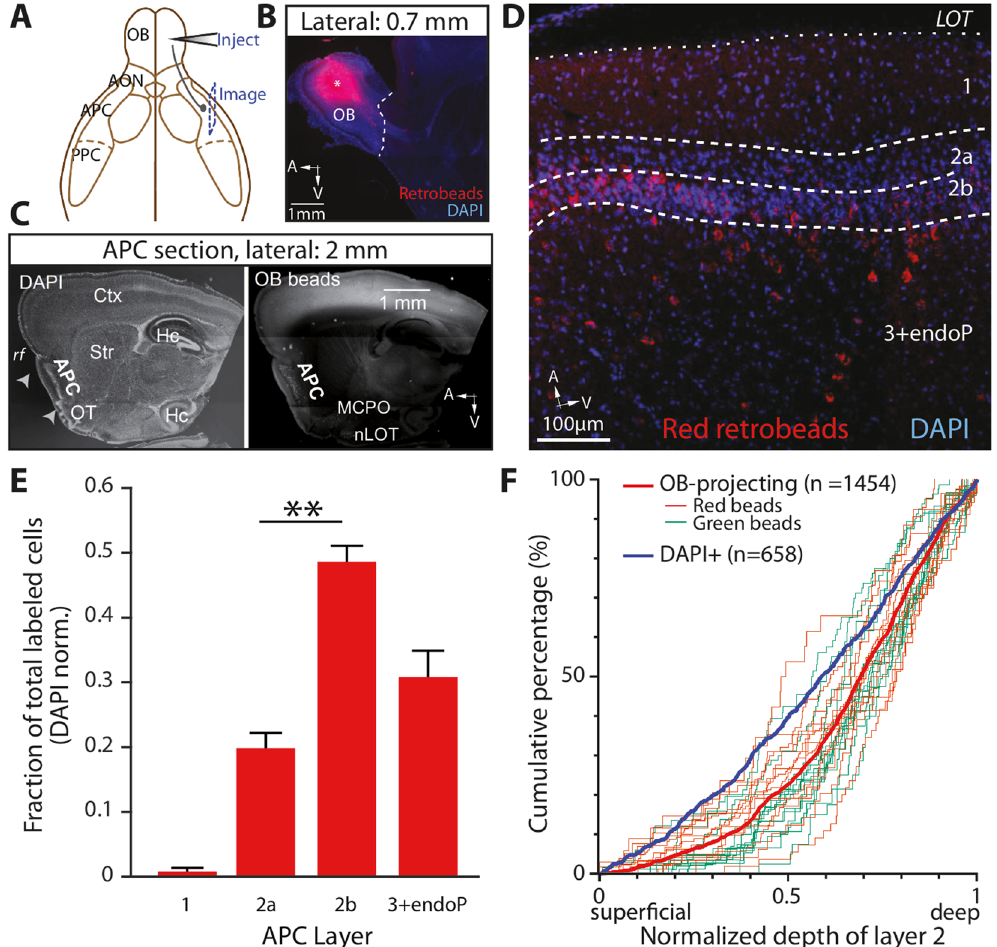
Figure 1. Layer 2b is the main source of feedback from the APC to the OB. ( A ) Schematic representation of injection of the tracer into the OB, and imaging from sagittal sections of the APC. ( B ) Injections were targeted to the granule cell layer of the OB. * , injection site. Red: retrograde tracer; blue: DAPI. ( C ) Representative sagittal section used for APC imaging. Left , DAPI labeling shows the main anatomical landmarks: dense cell layer 2 of the APC; rf: rhinal fissure; OT: olfactory tubercle; Hc: hippocampus; Ctx: neocortex and Str: striatum. Right , Retrogradely-labeled cells were found mainly in the APC in those sections. Some labeling was also observed in the MCPO: magnocellular preoptic nucleus and nLOT: nucleus of the lateral olfactory tract. ( D ) Higher magnification image showing retrogradely labeled cells across APC layers. Superficial limit of the layer 2 (border between layers 1 and 2a) is defined with a depth of 0 while a depth of 1 is the deep end of that layer (limit between layers 2b and 3). Red: retrograde tracer. Blue: DAPI. ( E ) Bar graph showing the relative fractions of retrogradely labeled neurons, normalized by the number of DAPI cells in each layer. OB-projecting neurons were heterogeneously distributed across APC layers (p < 0.0001, total cell count: 546 Retrobeads + , 4474 DAPI + cells, n = 13 sections, 11 mice, Friedman test). Within layer 2, cells were more densely found in layer 2b than in layer 2a (p = 0.005, n = 84 2a cells vs . 205 2b cells, Dunn’s multiple comparisons post-hoc test). ** P < 0.01. ( F ) Cumulative distribution of the OB-projecting cells within layer 2. On the x-axis, 0 indicates the border between layers 1 and 2a, while 1 is the limit between layers 2b and 3 (see panel D). The light green and red curves show the results from the counting obtained in a single optical section with green and red Retrobeads, respectively. Distributions obtained from green and red Retrobeads were not significantly different (p = 0.47, Kolmogorov-Smirnov test, n = 856 cells, 14 sections, 6 mice for the green Retrobeads, n = 598 cells, 13 sections, 6 mice for the red Retrobeads). The distribution of all the bead-labeled cells (thick red trace) was shifted to deeper part of the layer 2 compared to the distribution of the DAPI + cells (thick blue trace; p < 0.0001, Kolmogorov-Smirnov test, n = 658 DAPI +